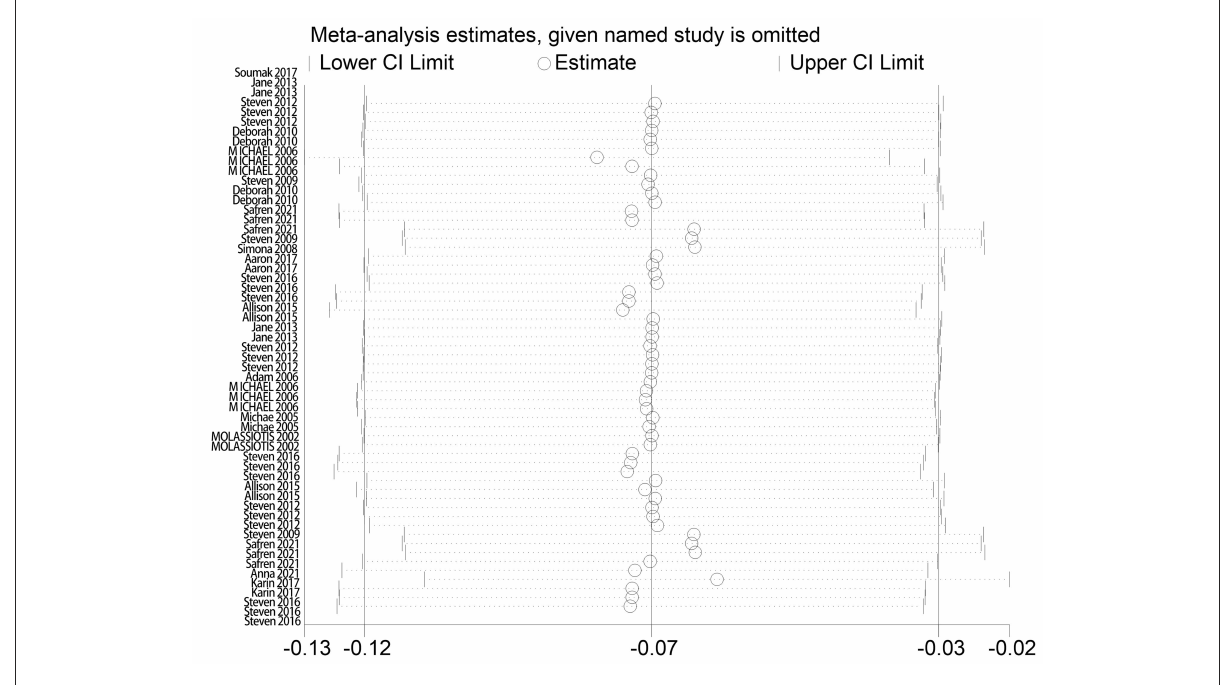
FIGURE1 Sensitivity analysis of depressive symptoms.